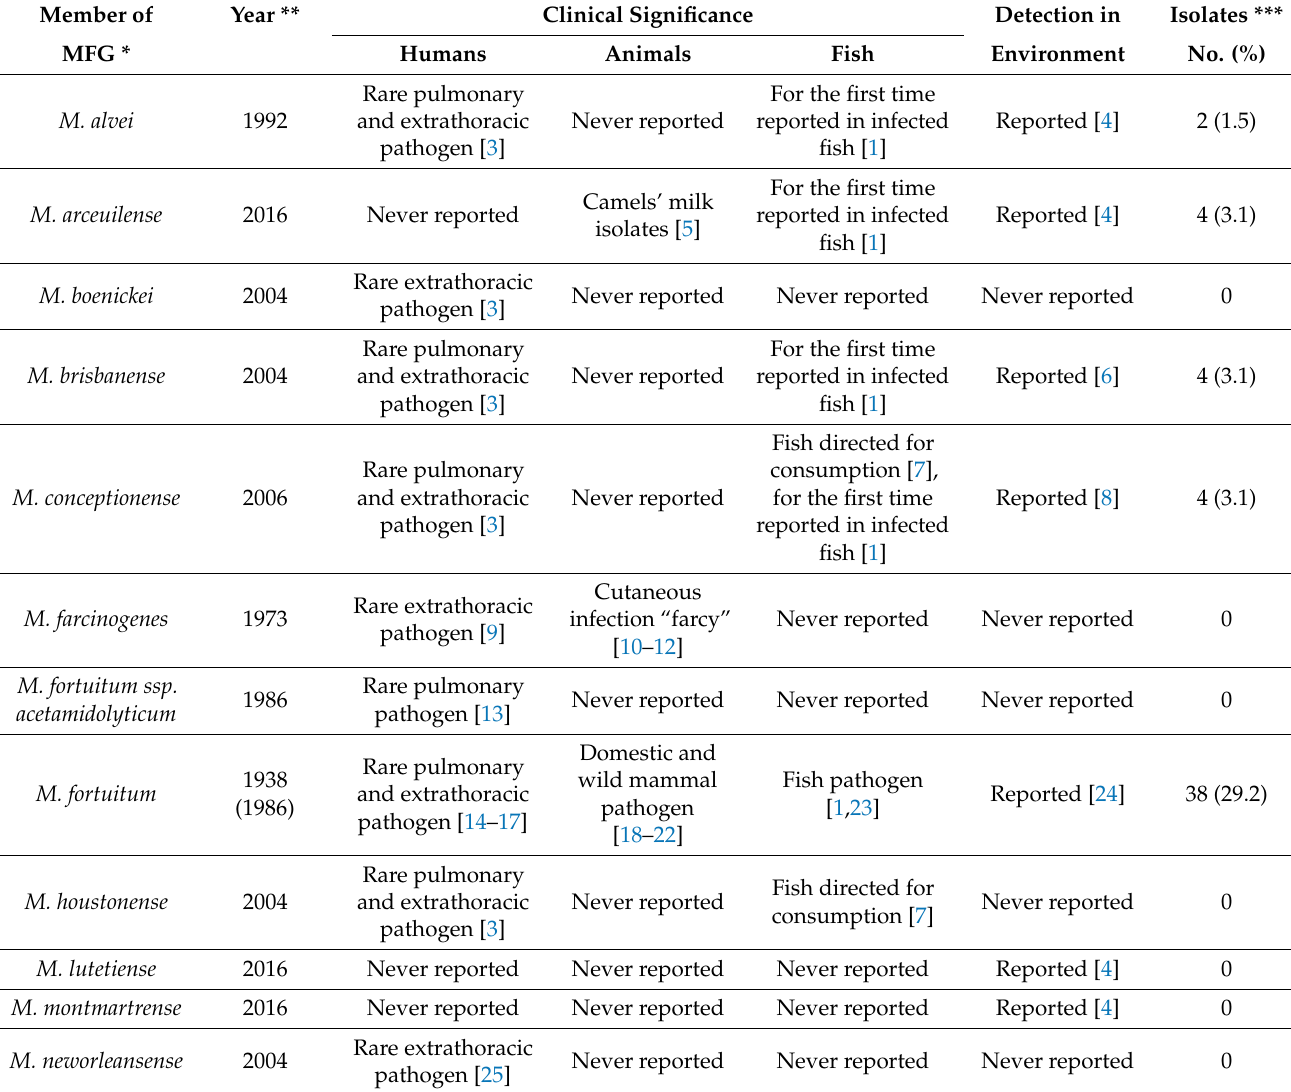
Table 1. Mycobacterium fortuitum Group members’ characteristics (year of description, pathogenicity/virulence for humans and animals, environmental prevalence and detection in fish). Clinical Significance Detection in Isolates